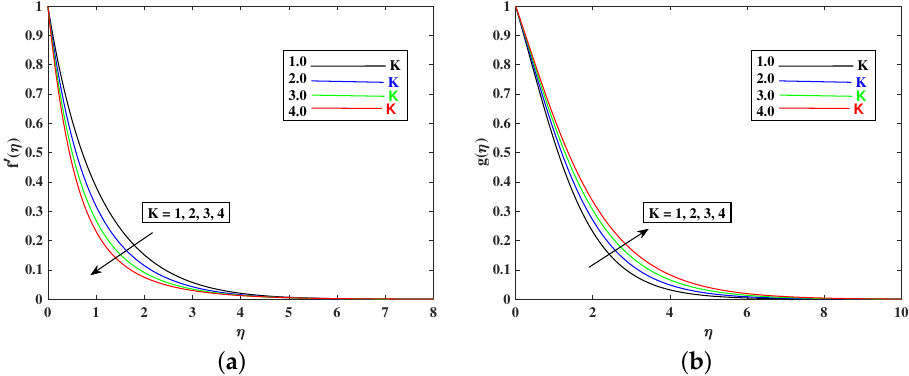
Figure 3. Variation of K to influence the velocity and temperature profile. ( a ) Variation of K to influence the velocity. ( b ) Variation of K to influence the